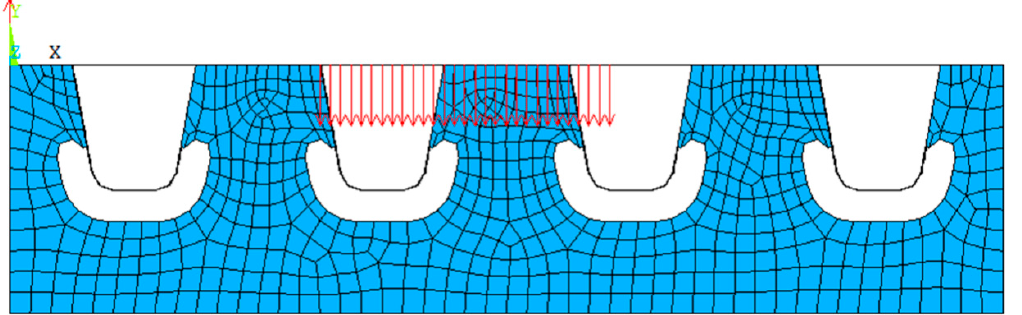
Figure 11. The worst loading position of the concerned point.